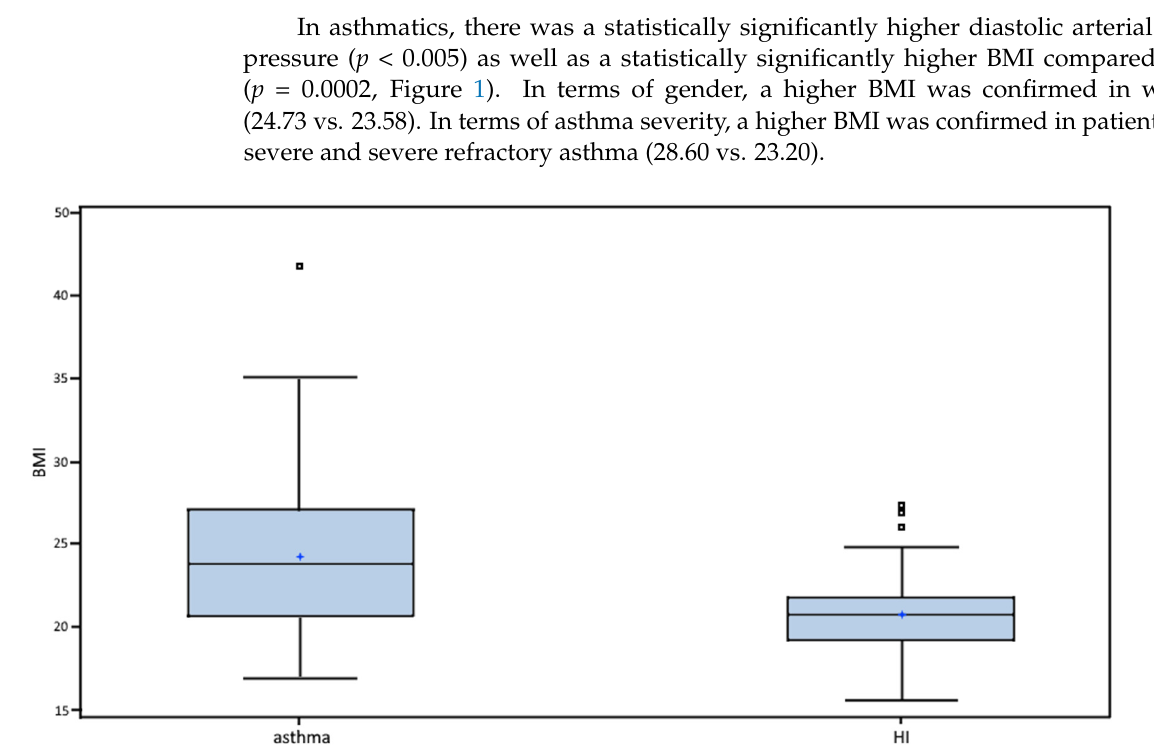
Figure 2. RHI in asthmatics vs. HI. Boxes indicate the inter-quartile range. Horizontal lines within boxes indicate medians. Whiskers extend to the highest or lowest values. RHI: reactive hyperemic index; HI: healthy individuals.